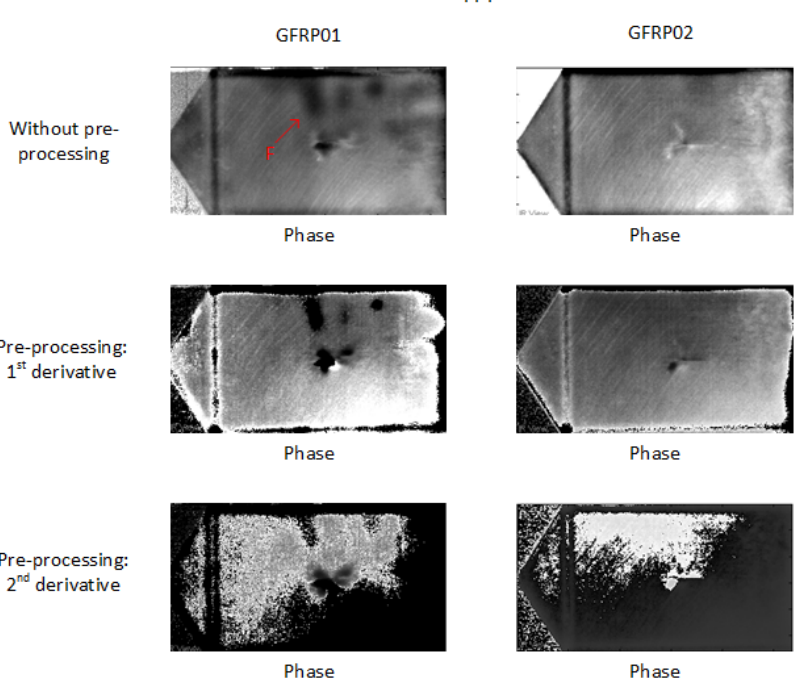
Figure 15. Thermographic results in PT for